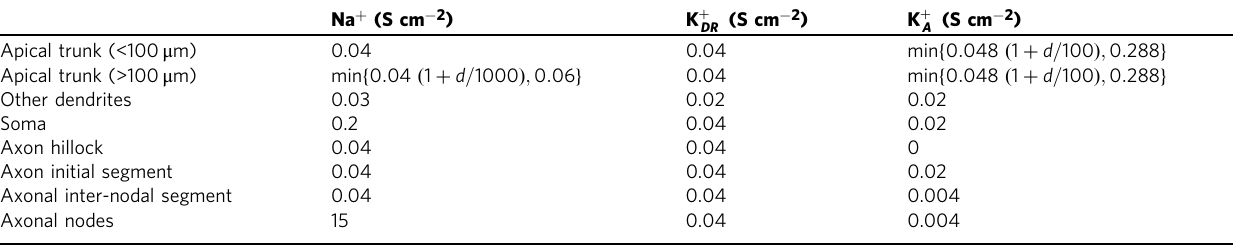
Table 1 Ion channel densities in the CA1 model.